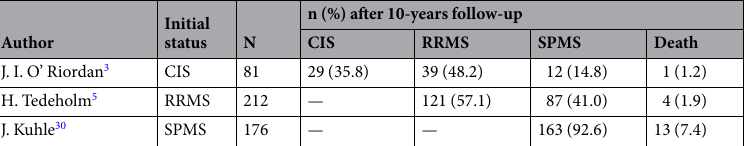
Table 2. Transition data and probabilities at 10-year interval. Initial status: the status of each patient cohort at the onset of longitudinal follow-up. n: number of patients; CIS: clinically isolated syndrome; RRMS: relapsing- remitting multiple sclerosis; SPMS: secondary progressive multiple sclerosis.